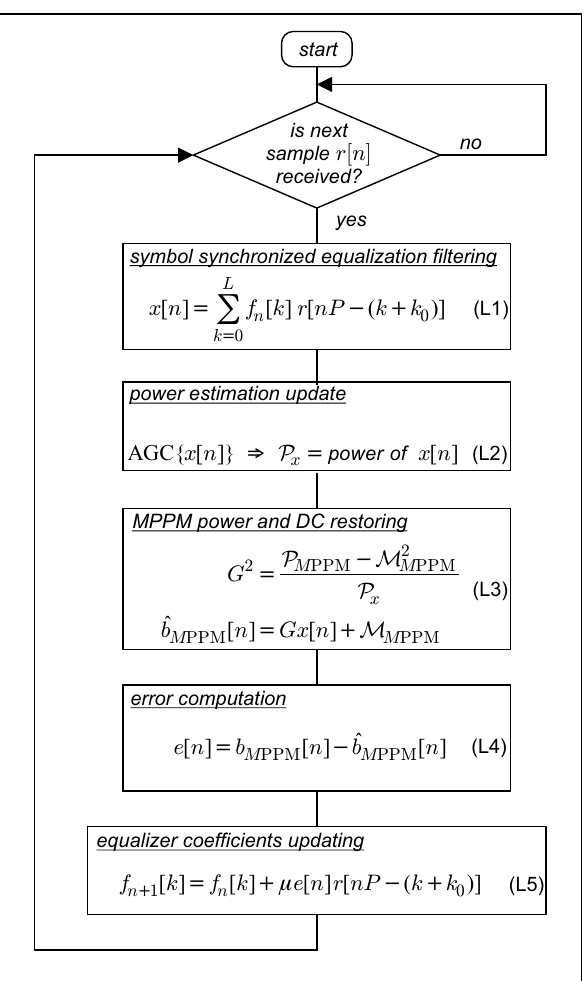
Figure 4. Least mean square (LMS) trained fractionally spaced equalizer (FSE) procedure. Direct component